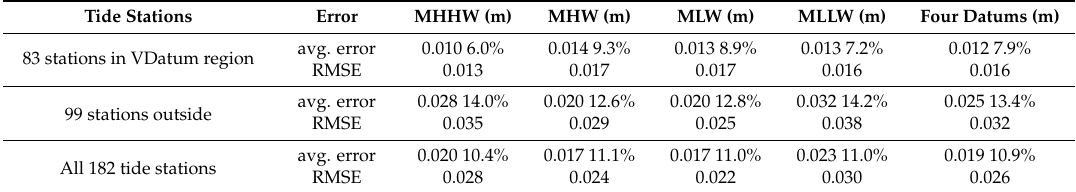
Table 3. Summary of averaged errors, in meters, for modeled datums at tide stations for the new grid.